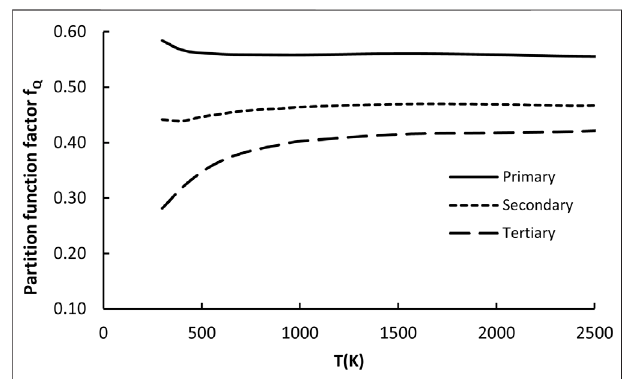
FIGURE 7 | Plot of the partition function factor ( f κ ) as a function of temperature for all 23 reactions considered in the representative set (R 2 – R 24 ).